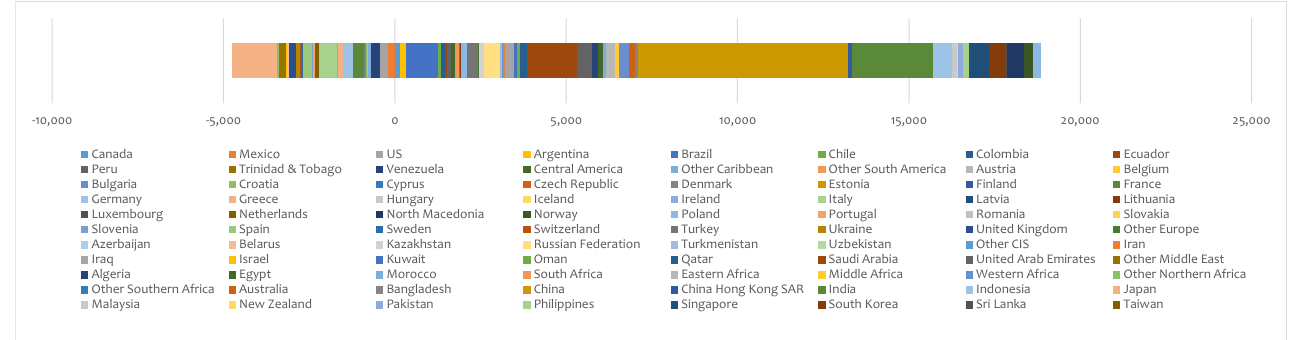
Figure 9. Change in global oil demand by country, 2006–2018 (data were collected from [22]).